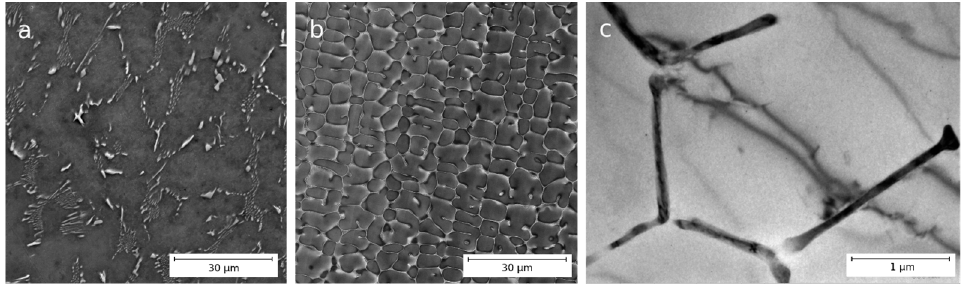
Figure 1. Microstructure of alloys CC ( a ) and EMC ( b ) in their initial states, SEM; ( c ) TEM micrograph of the EMC sample.